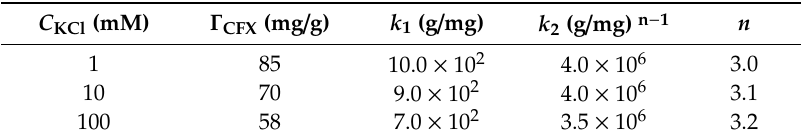
Table 2. The fitting parameters for CFX adsorption onto protein-modified nanosilia (ProMNS) at different KCl concentrations.